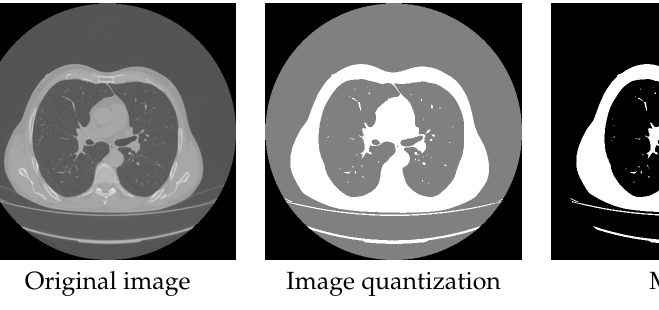
Figure 2. Preprocessing on Cheikh Zaid data.